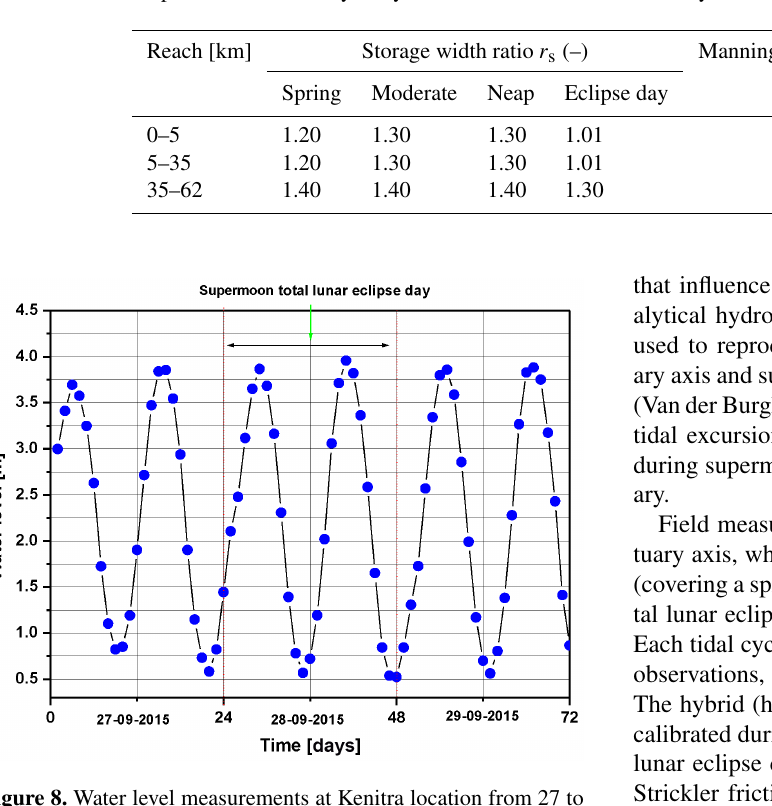
Table 4. Calibrated parameters for the hydrodynamic model of the Sebou estuary.